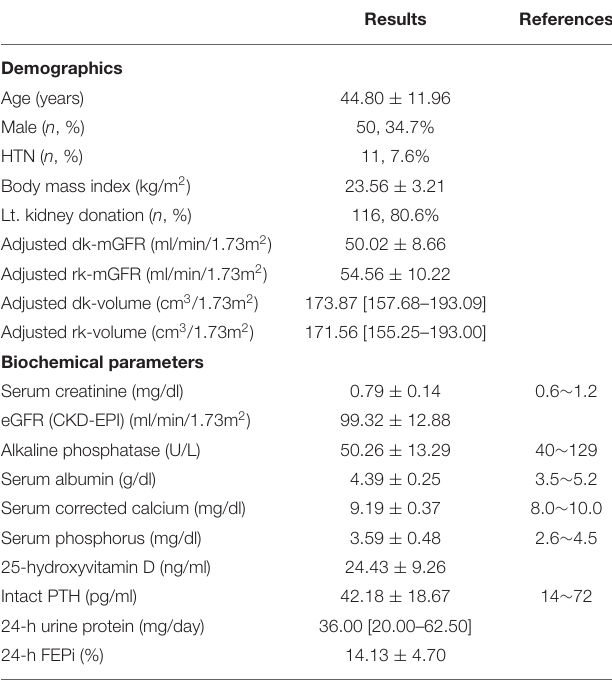
TABLE 1 | Baseline characteristics of the living kidney